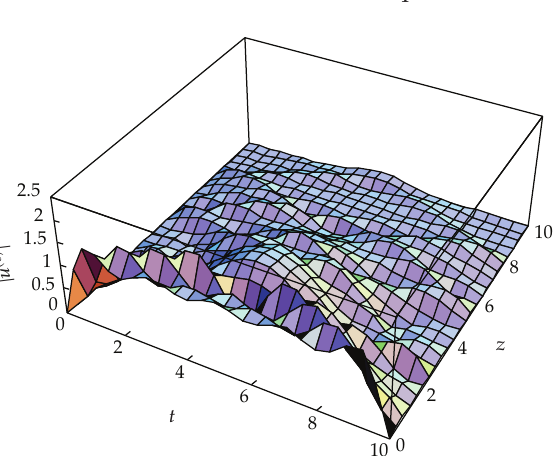
Figure 10: The zero-order approximation of | u (cid:3) 0 (cid:4) | at α (cid:8) 1, T (cid:8) 10, γ (cid:8) 02 with considering only one term in the series (cid:3) M (cid:8) 1 (cid:4)